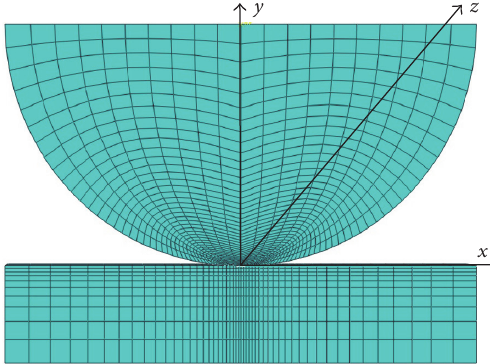
Figure 1: Fine element mesh in the contact problem.